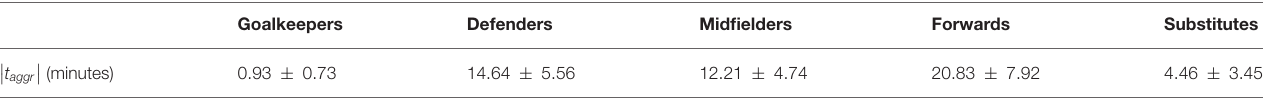
Table A1. Aggregated times by position. Total time accumulated by a player at a distance lower or equal than D = 2 m to all his rivals, by position.